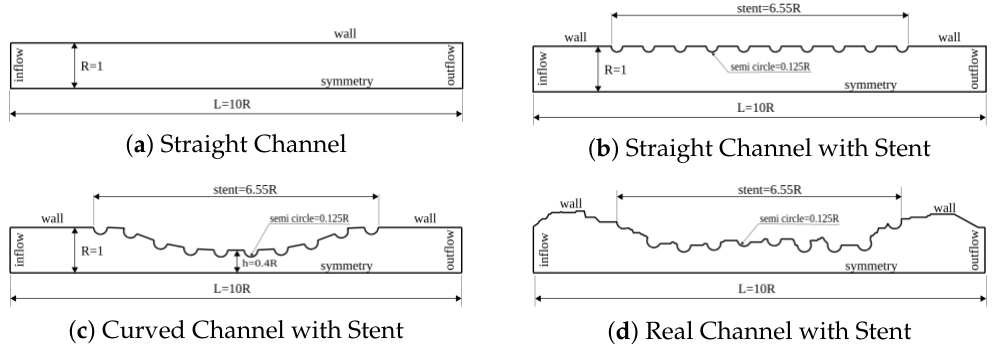
Figure 2. Nondimensional domains for the dynamics analysis of concentration diffusion in coronary artery with drug- eluting stent. The lumen dimensionless width used was R = 1 and the lumen length was L = 10 R for the ( a – c ) cases. The drug-eluting stent of length equal to 6.55 R was modeled for ( b – d ) geometries by 10 uniform spaced semi-circles with radius equal to 0.125 R. An atherosclerosis was considered for ( c ) geometry, where a sinusoidal equation was used to model 40% of channel obstruction. For ( d ) case, the geometry was obtained through an image processing in an obstructed coronary artery due to the